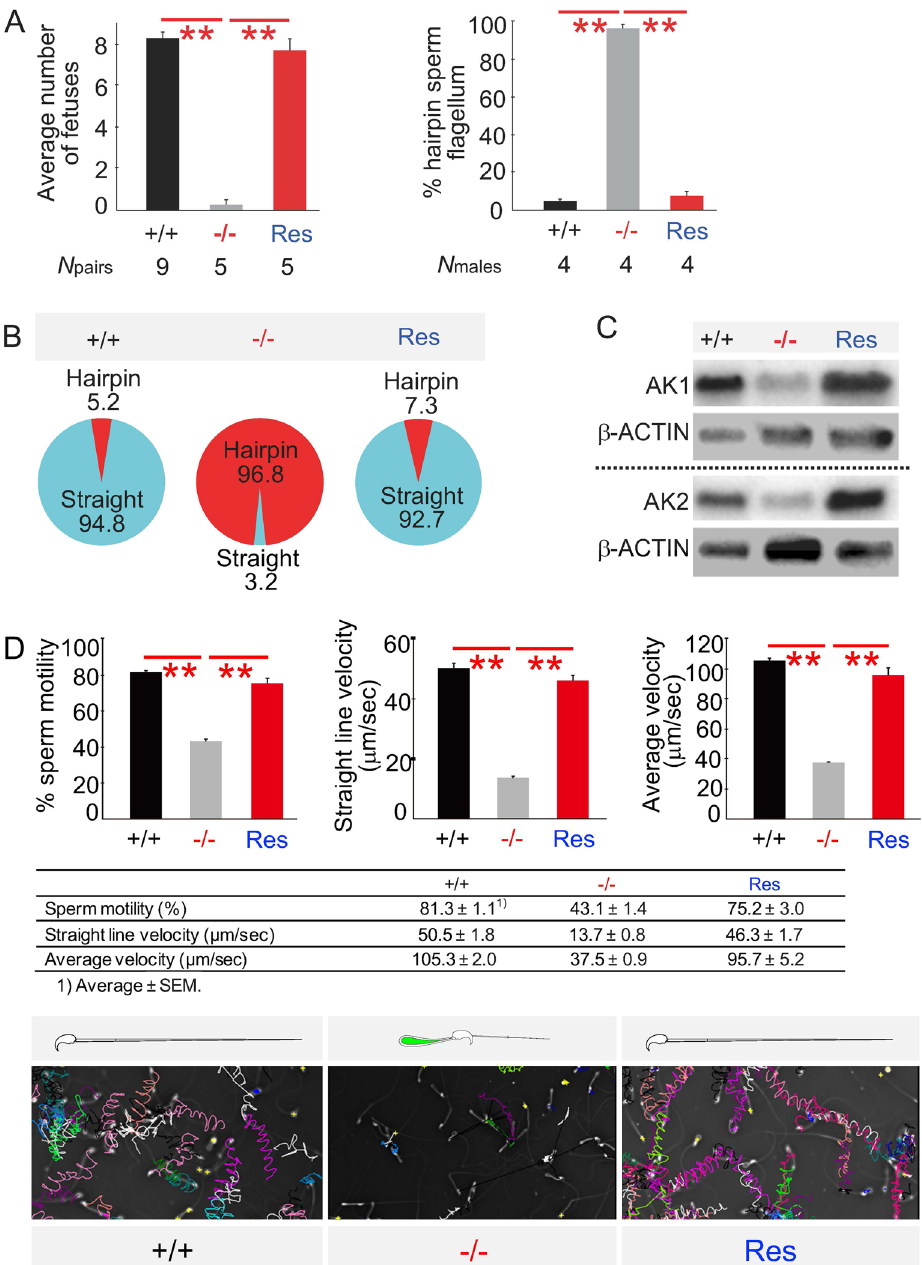
Figure 7. Rescue experiments. + / + : Odf4 +/+ . −/−: Odf4 −/− . Res: Rescue. The rescue male was made by insertion of the Odf4-Egfp gene into Odf4 −/− (Fig. S12) to show that rescued Tg(Odf4- Egfp) Odf4 −/− males restore a healthy reproductive phenotype to Odf4 −/− males. ( A ) (Left) Fertility rate: 8.3 ± 0.3 (+ / +), 0.3 ± 0.3 (−/−), and 7.8 ± 0.6 (Res). (Right) Percentage (%) postcopulatory hairpin sperm flagella: 5.0 ± 0.8 (+ / +), 96.0 ± 2.4 (−/−) and 7.5 ± 2.7 (Res). Steel–Dwass test (nonparametric test). ( B ) Restoration of percentage (%) of hairpin flagella in cauda epididymal spermatozoa. ( C ) Cropped images of western blotting with antibodies against AK1 (Top) and AK2 (Bottom). Both AK1 and AK2 signals were detected in rescued spermatozoa as strong as in Odf4 +/+ spermatozoa. Further cropped images are shown in Fig S12D. These original full-length images with different exposure times are shown in the supplementary SD16. ( D ) (Top) Sperm movement analysis by SMAS. (Left) Percent (%) sperm motility. (Middle) Straight line velocity. (Right) Average velocity. These movements were significantly lower in Odf4 −/− mice than in Odf4 +/+ mice but were restored in rescued males. Welch’s t test (two- tailed analysis). (Middle) Table shows raw data. The motility level of the rescued spermatozoa is almost the same as that of the wild-type (+ / +) spermatozoa. (Bottom) Representative tracts (colors for individual sperm). N males ( N sperm): 5 (10,406), 5 (9,030) and 3 (12,517) for Odf4 +/+ , Odf4 +/- and rescue males, respectively. ** P <